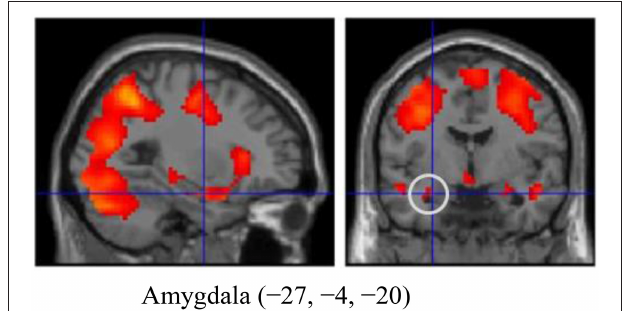
FIGURE 1 | The amygdala region (MNI coordinates: − 27, − 4, − 20) during emotion generation (Look Negative - Look Neutral), with the statistical threshold set to p < 0.001 for height, corrected to p < 0.05 for multiple comparisons according to cluster size and assuming the whole brain as a search volume. In this figure, activation is presented at a threshold of p = 0.05 for illustration purposes only. Activation is shown on an SPM8 canonical T1 image.